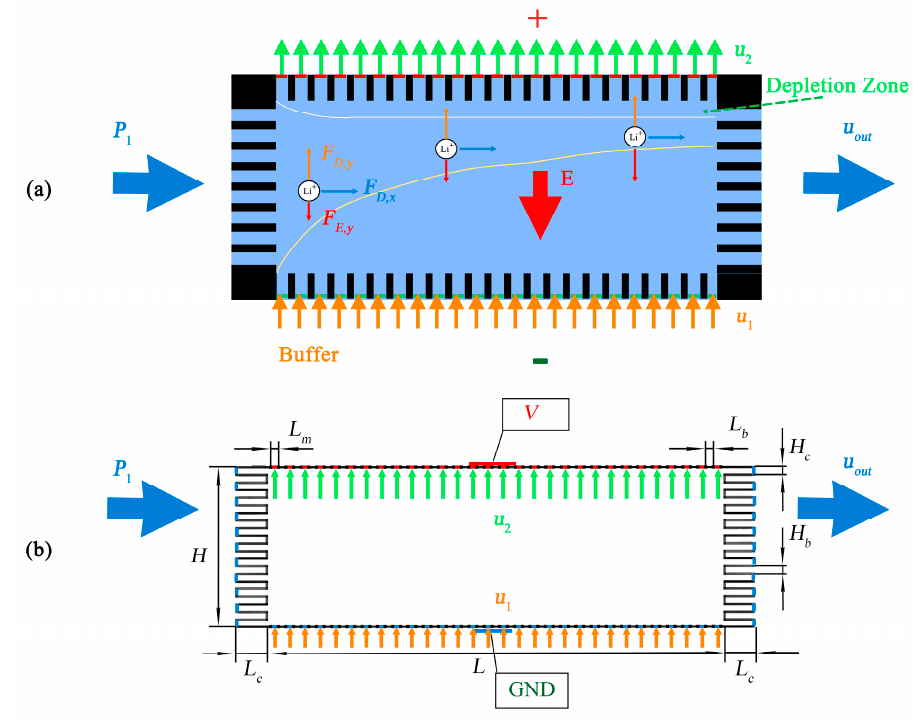
Figure 1. ( a ) Schematic of FF-ICP system for ion concentration and separation. ( b ) The simulation model. Table 1. The transport parameters of the ions in the raw brine [35].